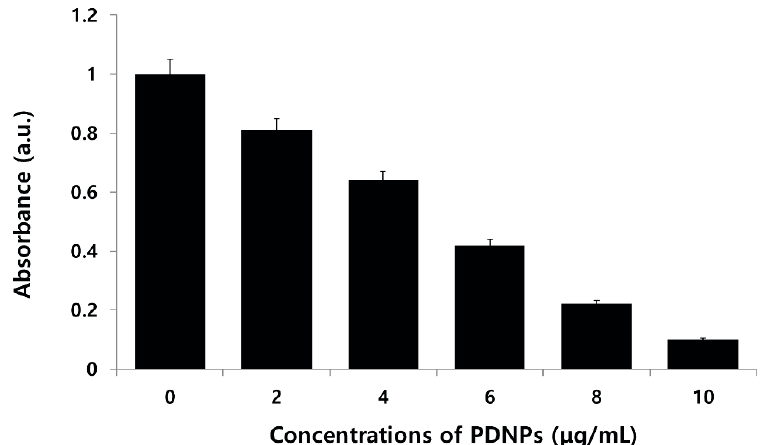
Figure 6. Effects of palladium nanoparticles (PdNPs) on cell viability of human ovarian cancer cells. Viability of A2780 human ovarian cancer cells was determined after 24-h exposure to different concentrations of PdNPs using the water-soluble tetrazolium (WST)-8 assay. Results are mean ± standard deviation of three independent experiments. Significant difference was observed above 4 μ g/mL. Viability of treated compared to untreated cells using Student’s t -test, p < 0.05.